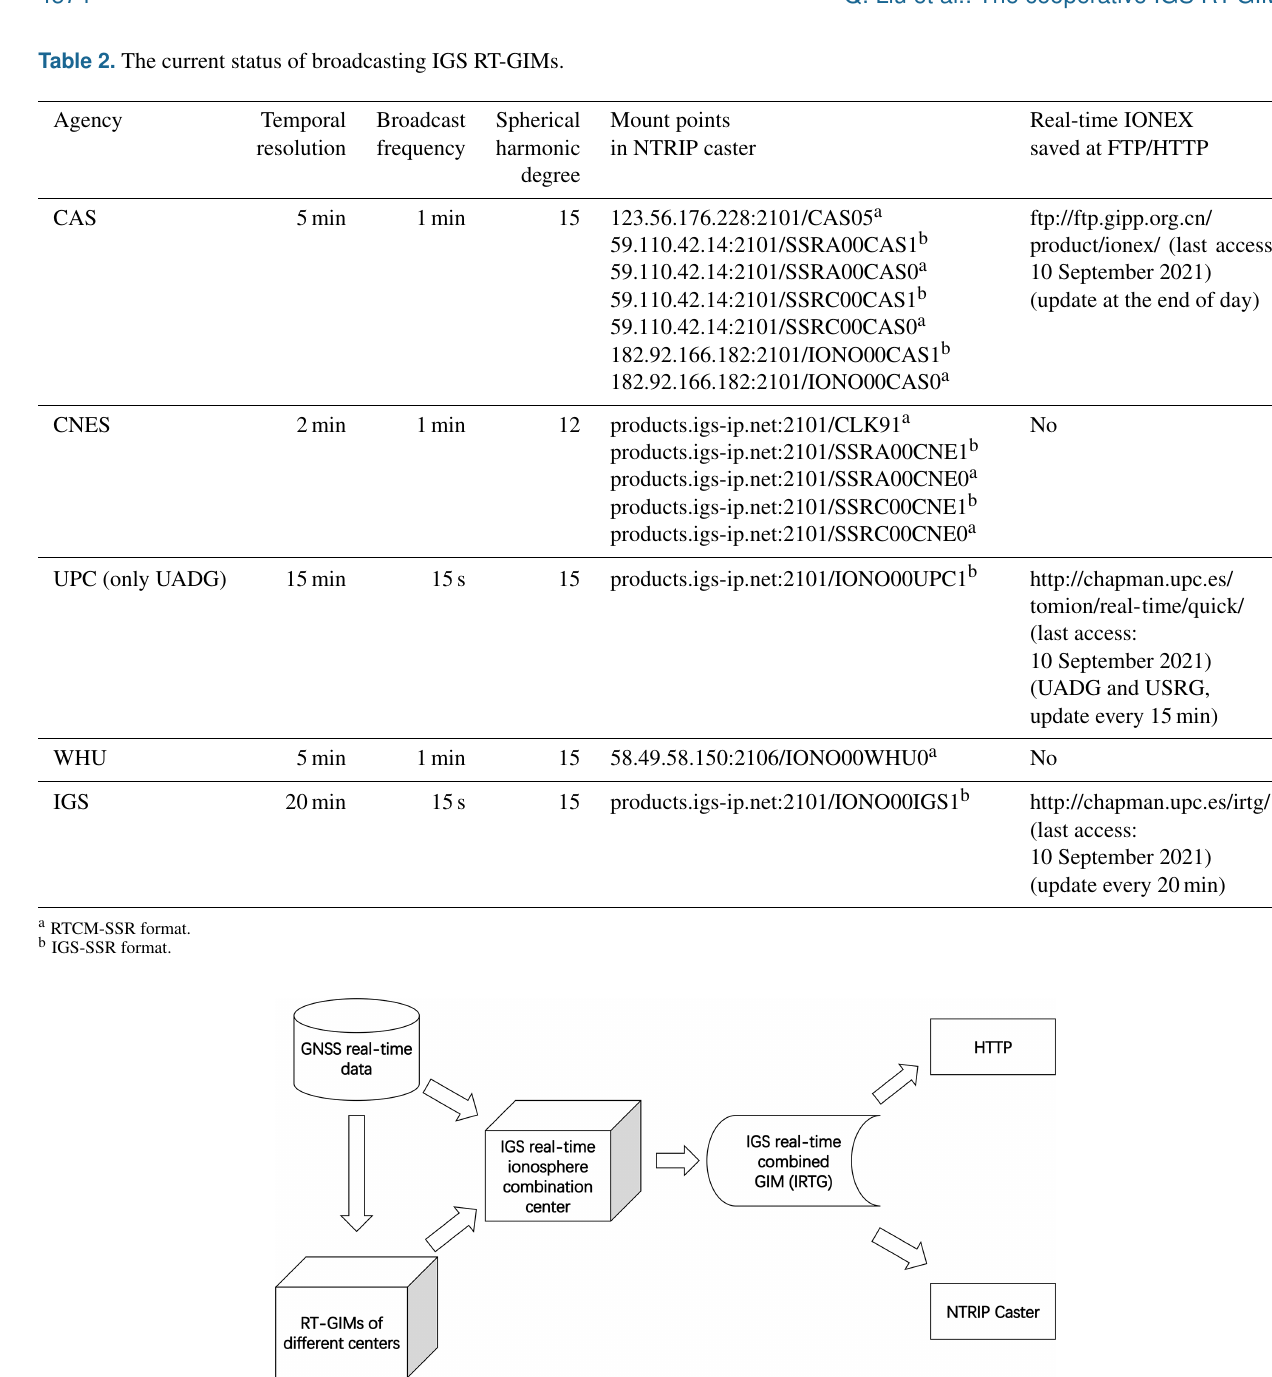
Figure 2. Data flow for the IGS real-time combined